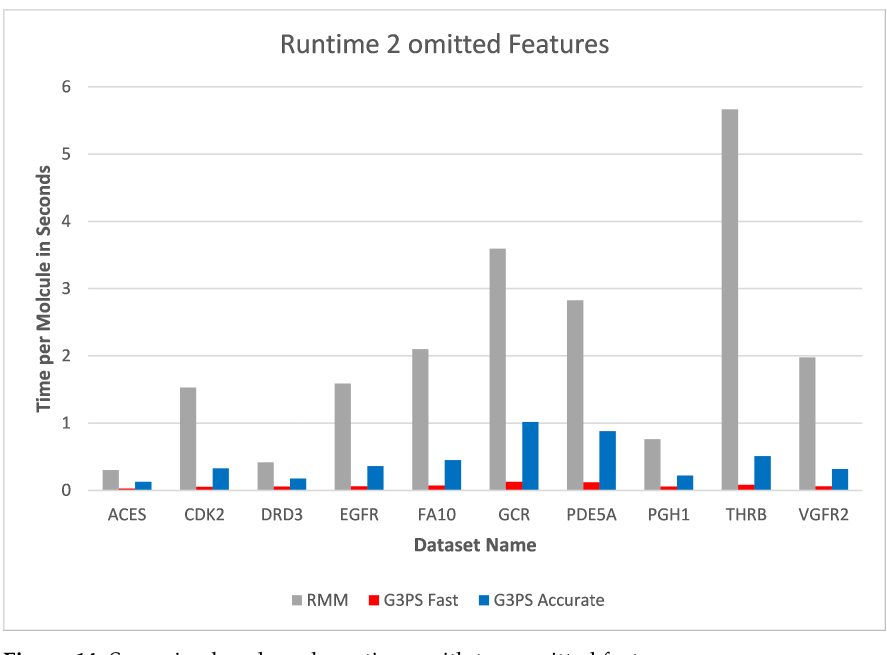
Figure 14. Screening benchmark runtimes with two omitted features.